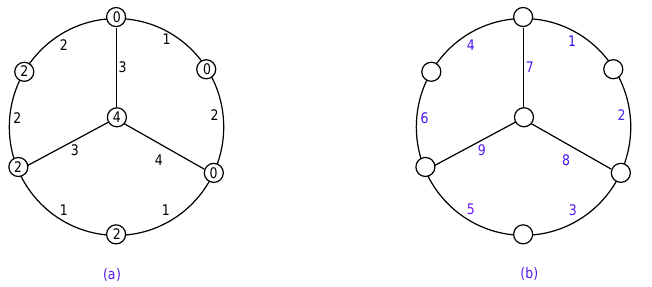
and ( b ) The edge weights of J 1 3,2